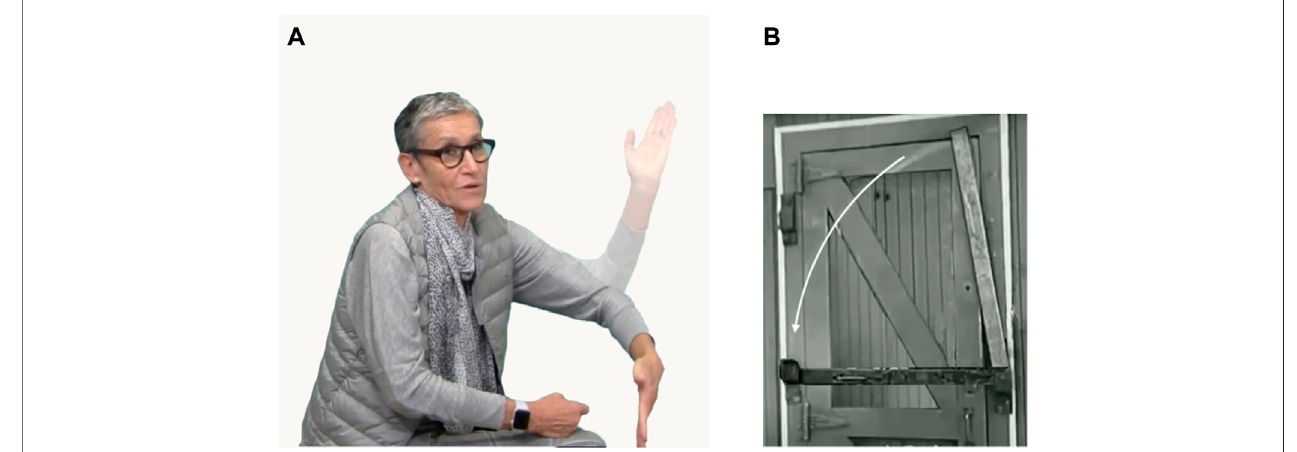
FIGURE 1 | (A) Iconic co-speech manual gesture indicating a latch coming down and locking the door to a lion ’ s cage (pictured in (B)